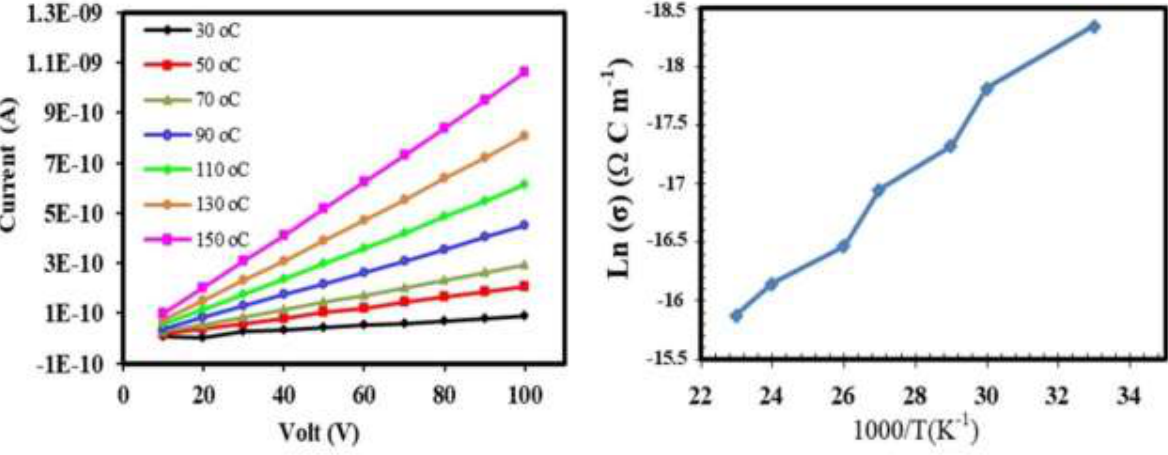
Figure 6: (a) I-V characterization, (b) shows the plot of Arrhenius (ln (σ) vs. 1/T) of WO 3 thin films at 80 molarity